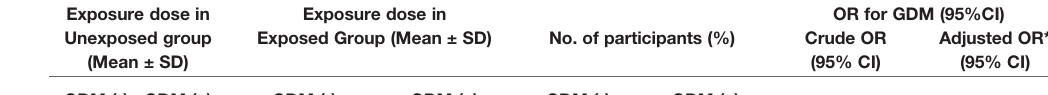
TABLE 3 | Associations of cumulative exposure to the COVID-19 lockdown with gestational diabetes mellitus. Exposure dose in Exposure dose